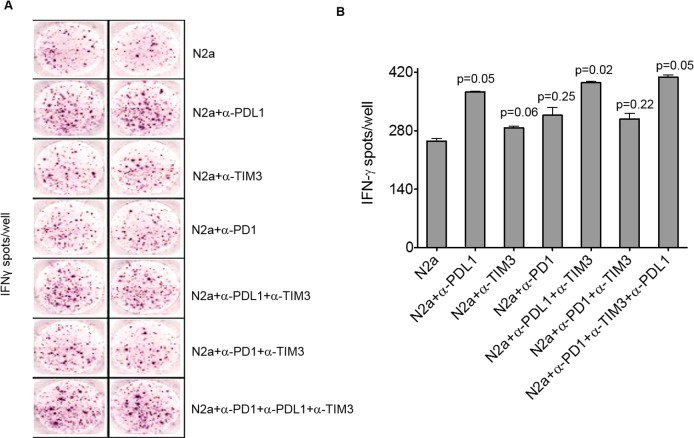
Programmed cell death-ligand 1 (PD-L1) blockade boosts interferon gamma (IFNγ) production of tumor-infiltrating lymphocytes (TILs) in vitro.CD8+ TILs isolated from tumors of mice treated with α-CTLA-4+vaccine were cocultured with wild-type (WT) N2a cells at a 10:1 ratio, for 40 hours in an IFNγ Enzyme-Linked ImmunoSpot (ELISpot) assay. Where indicated, N2a cells were blocked with 10 μg/ml α-PD-L1 for 24 hours prior to coculture, and blocking was maintained during the assay. Also as indicated, α-PD1 and α-TIM3 were added to the reactions at 10 μg/ml for the duration of the assay. Panel A shows actual IFNγ spots/well imaged from ELISpot assay in duplicate. Panel B graphs enumerated spots captured from an ELISpot reader in which each spot corresponds to a T cell producing IFNγ (unpaired 2-tailed Student t test, p < 0.0485 where significant, p > 0.0595 where not significant).